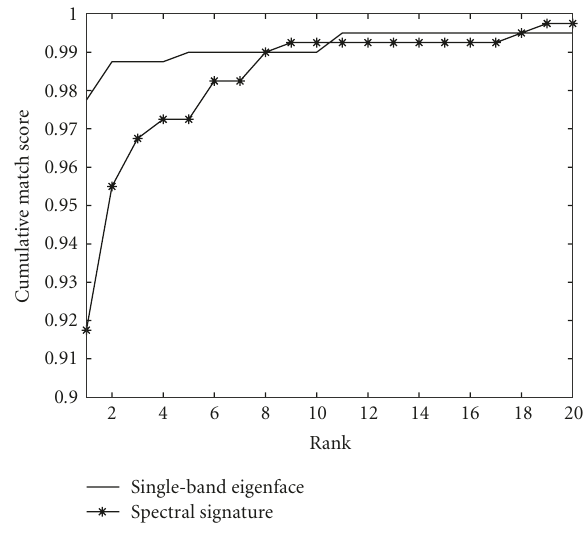
Figure 3: Cumulative match scores of single-band images at di ff erent wavelengths.